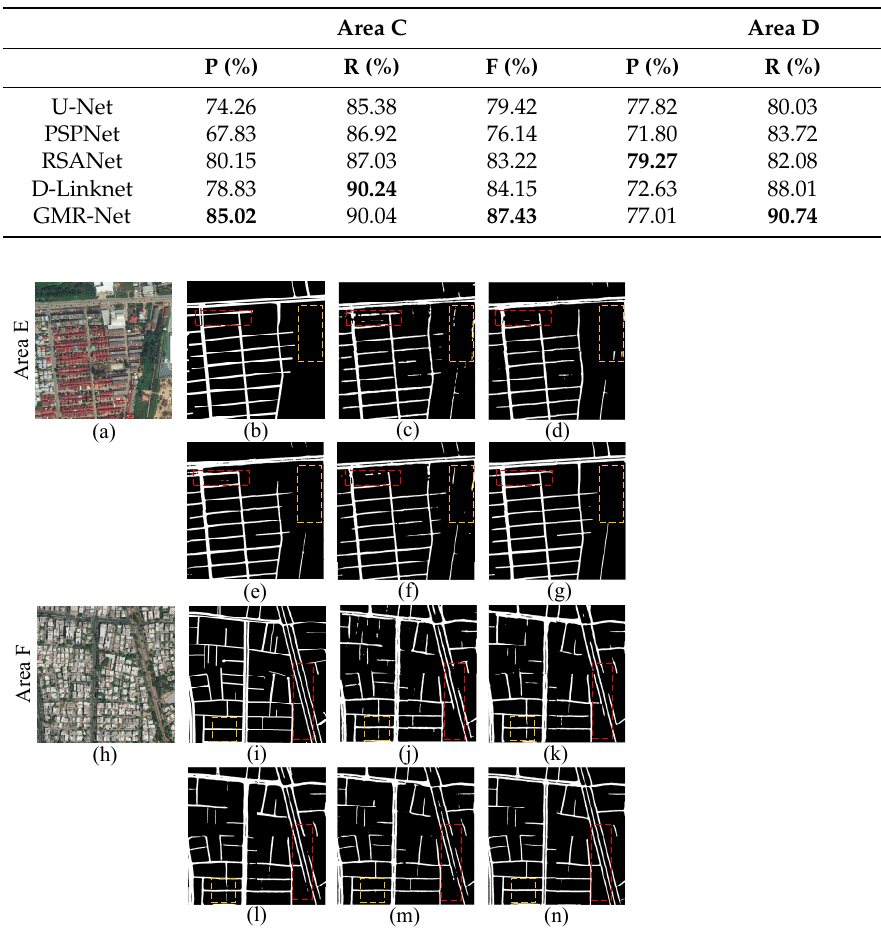
Figure 9. A classification results comparison for study areas E and F. ( a , h ) Input images; ( b , i ) ground truth; ( c , j ) U-Net; ( d , k ) PSPNet; ( e , l ) RSANet; ( f , m ) D-Linknet; and ( g , n ) GMR-Net. The red-dashed frame shows areas where judgement is missing and the yellow-dashed frame is the false judgment area. Table 7. A results comparison between the GMR-Net method and other methods in research areas E and F, where the values shown in bold are the best.